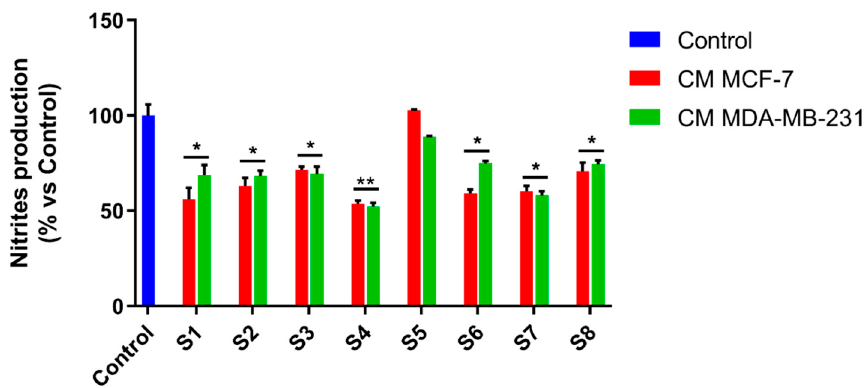
Figure 7. Salvia officinalis extracts decrease pro-inflammatory effects mediated by breast cancer cells conditioned media. Nitrites production was measured in RAW 264.7 cells after 24 h of treatment with conditioned media from MDA-MB-231 or MCF-7 cell lines (exposed before to IC 50 values of S1–S8 extracts, for 24 h). Values are the mean ± SD of three independent experiments, each one performed in triplicate. P -values were calculated vs. control; * p < 0.05; ** p < 0.01.